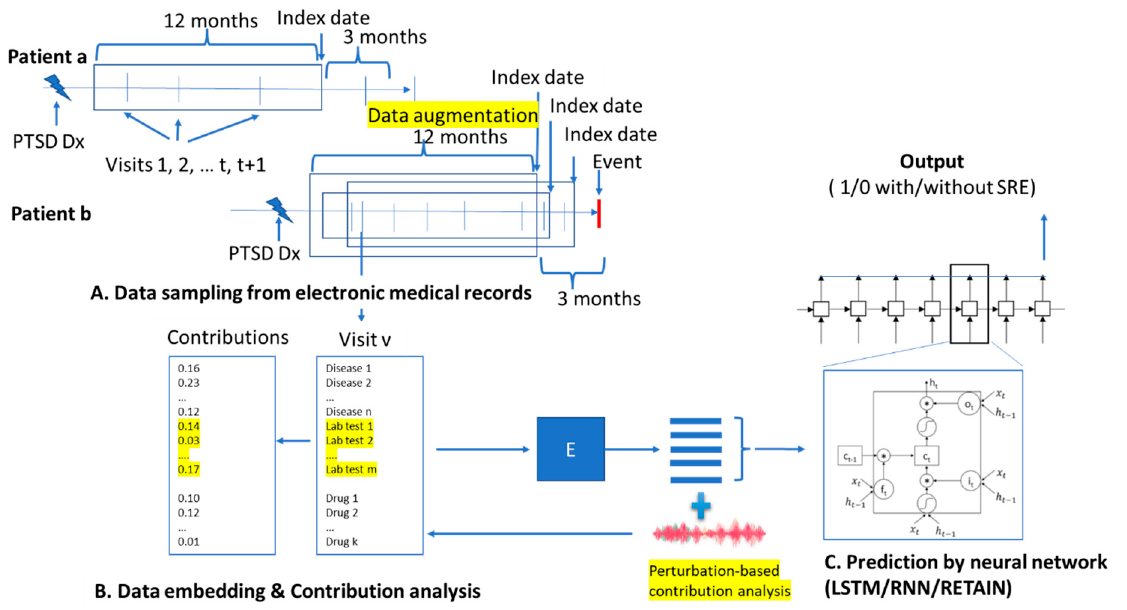
Figure 1. The overview of DeepBiomarker. ( A ) Data sampling from electronic medical records, ( B ) data embedding, and ( C ) prediction by neural network, with LSTM as the basic prediction units. Perturbation-based contribution analysis was used to identify important features. RNN: recurrent neural network; LSTM: long short-term memory; RETAIN: REverse Time AttentIoN model. PTSD: post-traumatic stress disorder; Dx: diagnosis; SRE: suicide-related event.